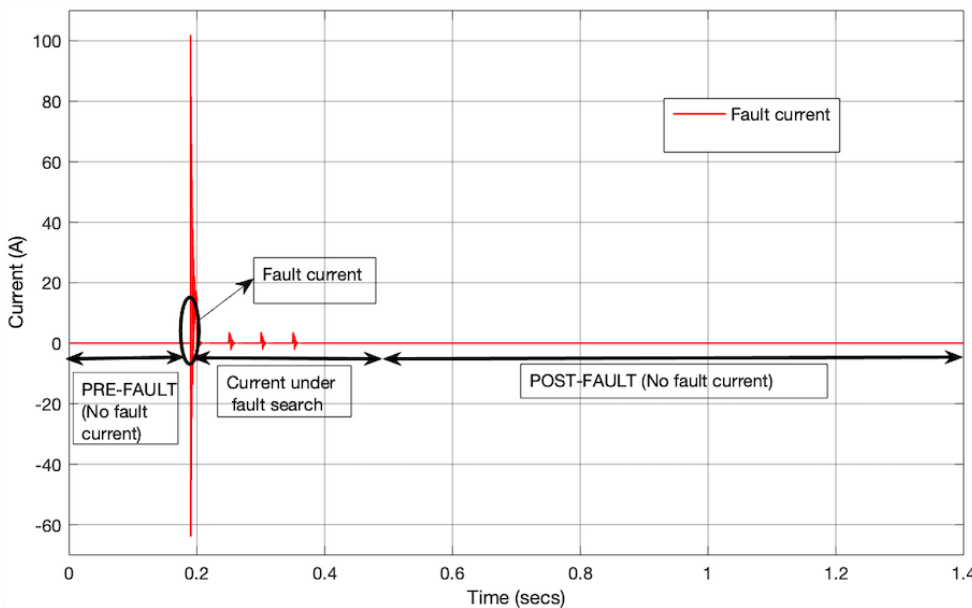
Figure 13. Fault current in the LVDC microgrid during normal operation, during the fault, and when the fault is isolated.